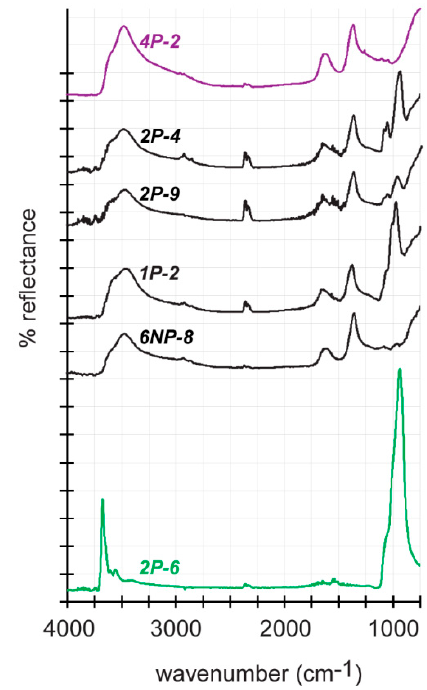
Figure 6. FTIR spectra from the boundary between stitchtite nodules and the serpentine-host, deliberately including both stitchtite and serpentine in the analyses volume, in samples 2P, 6NP, and 1P (black lines). Also shown are the FTIR spectra of stichtite (purple line, top) and serpentine host (green line, bottom) from Figure 3.